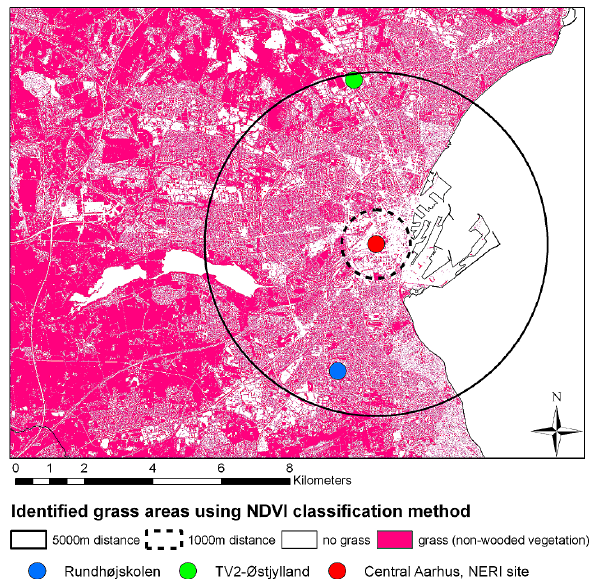
Fig. 3. Possible grass areas in the city of Aarhus based on the NDVI classification methodology described in Sect. 2.2, with a ground res- olution of 0.6m. High density grass areas are displayed as large, intense pink areas and lower density areas as more a of mixture of pink and white pixels. Areas without grass are completely white. Circles are distances from central Aarhus at 1000m and 5000m, respectively.